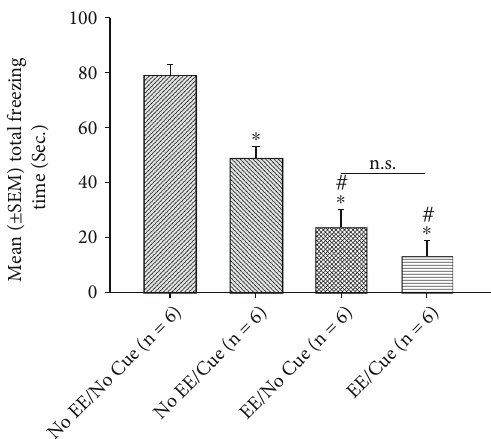
Figure 6: Mean ( ± SEM) total freezing time from the merged data in sessions 1-3 for the no EE/no cue, no EE/cue, EE/no cue, and EE/ cue groups ( n = 6 , per group). EE: environmental enrichment. ∗ p < 0 : 05 indicates signi fi cant di ff erences compared to the no EE/no cue group; # p < 0 : 05 indicates signi fi cant di ff erences compared to the no EE/cue group. (n.s.): nonsigni fi cant di ff